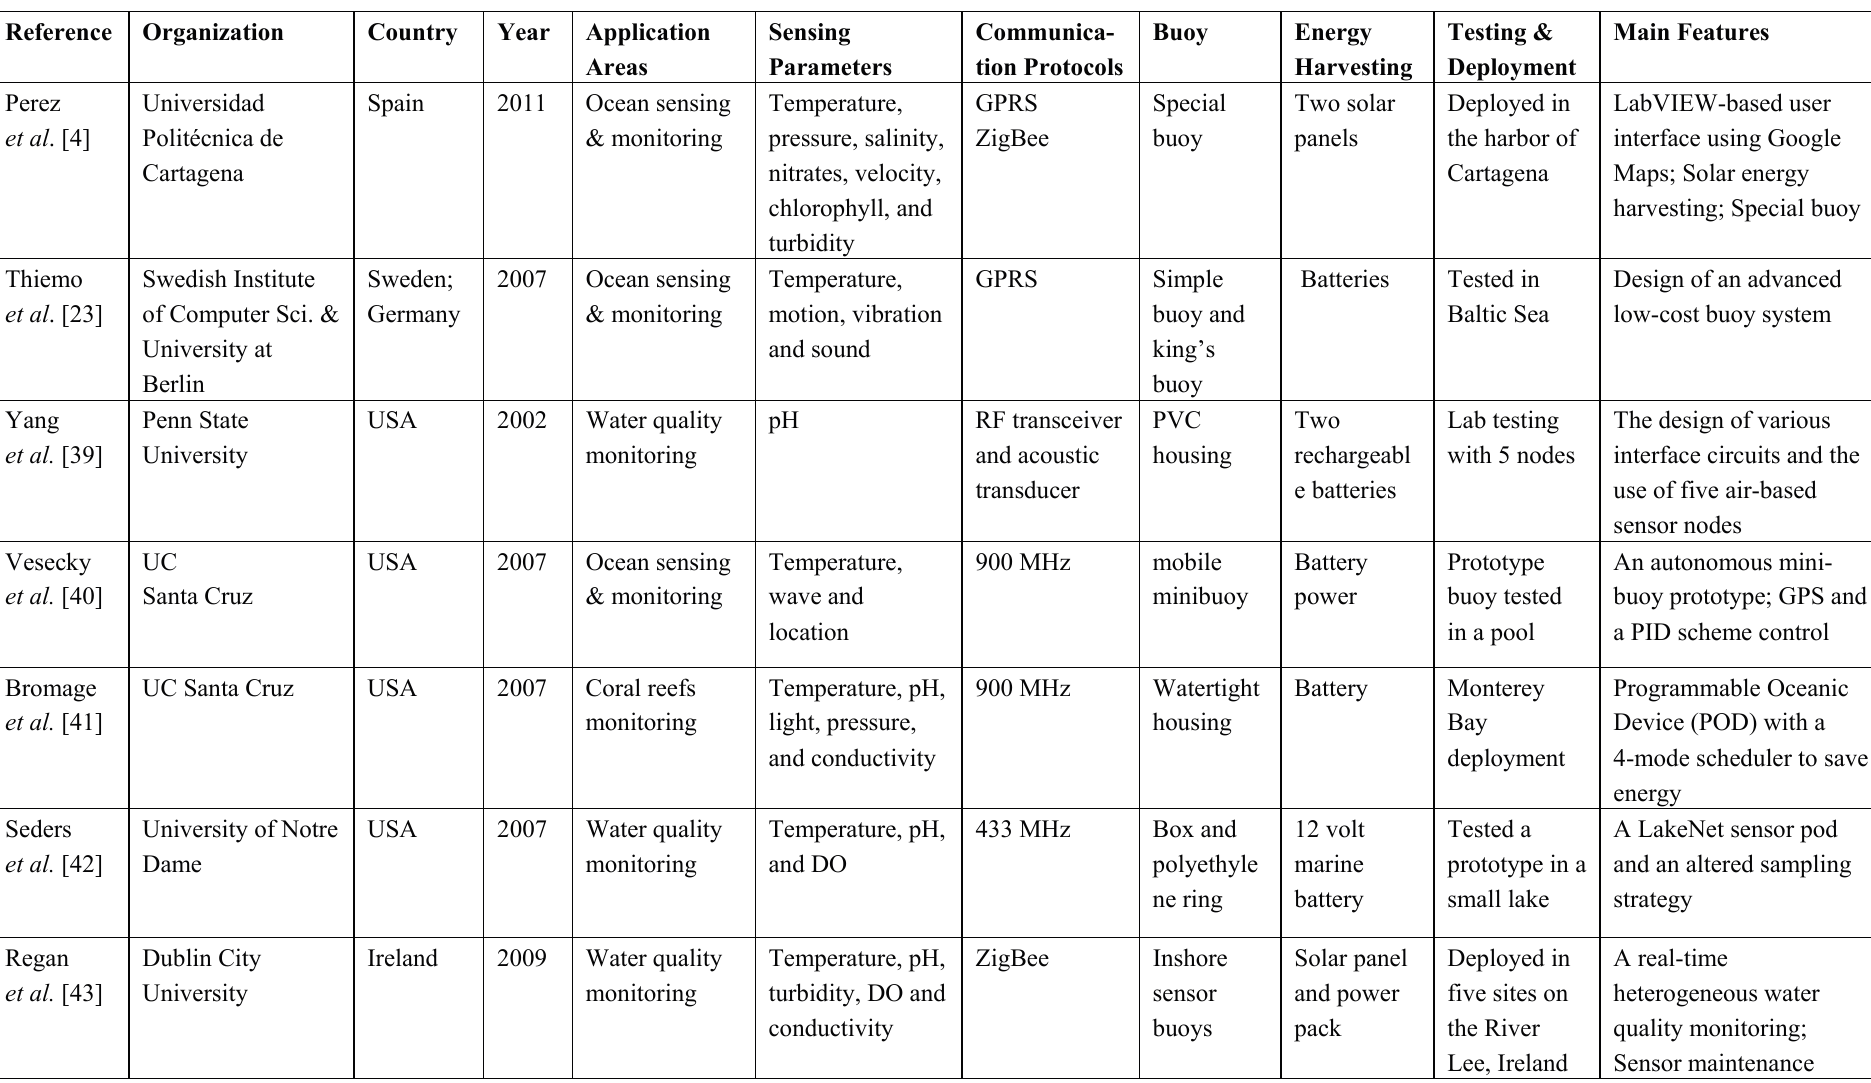
Table 3. Summary of WSN-based marine environment monitoring projects, systems and